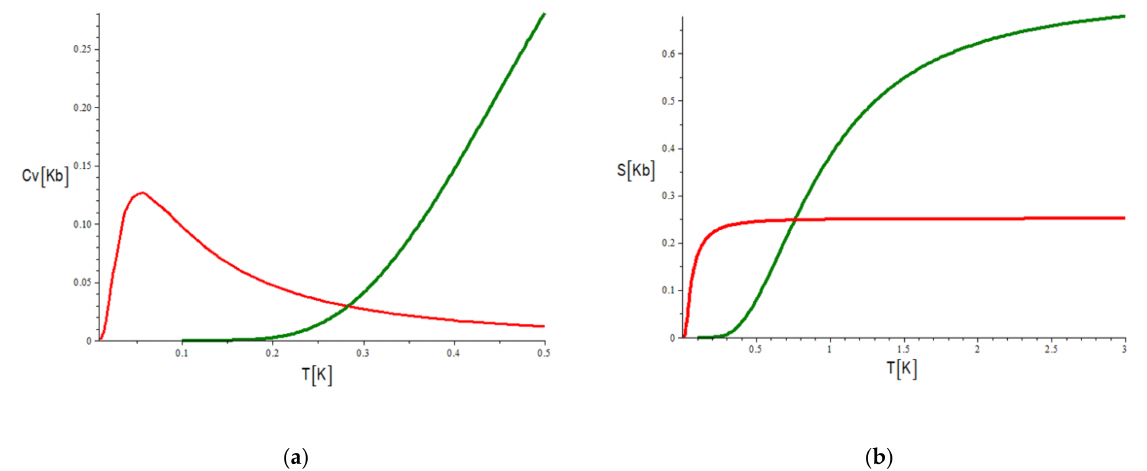
Figure 4. Specific heat and entropy with a version of overlapped analytical formulas for the two global states, in ( a ) the specific heat of the two phases: the fast increase up to 0.1 K is the boson condensate in coherence with the Figures 1 and 2 and fast decreases up to disappear. Then it is generated the magnetic plasma in coherence with results of Figure 3. In ( b )